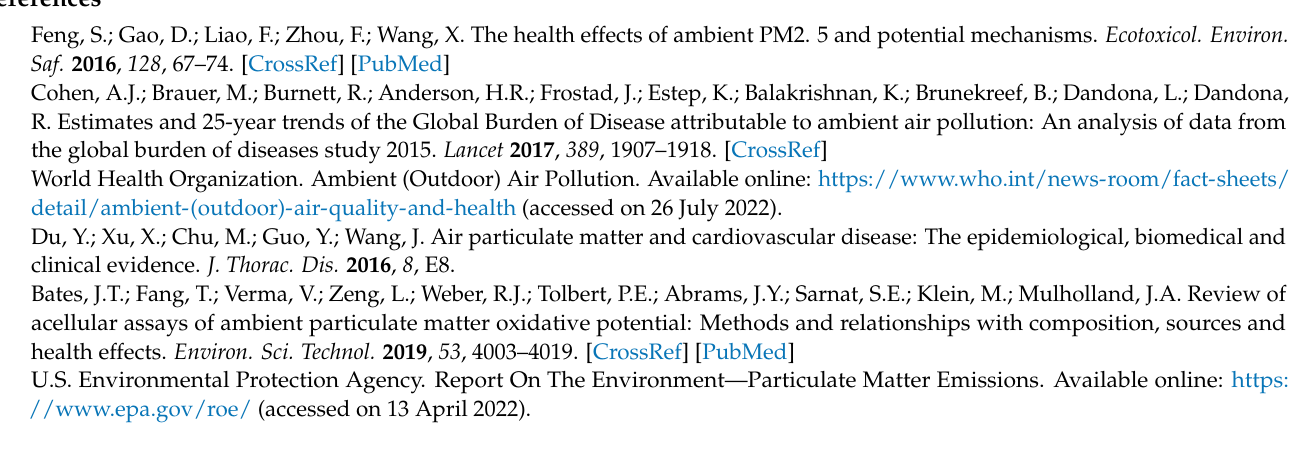
PM 2.5 and PM 10 with Decreased Cognitive Function (n = 4175). Supplementary Table S2: Relationship between Tertile of PM 2.5 and PM 10 and Cognitive Score (n = 4175). Supplementary Table S3: Asso- ciation between PM 2.5 and PM 10 and Cognitive Score by Sex (Women = 2305; Men = 1870). Sup- plementary Table S4: Association between PM 2.5 and PM 10 and Cognitive Score by Age Group (50–65 years = 1665; 65–75 years = 1483; >75 years = 1027). Supplementary Table S5: Association between PM 2.5 and PM 10 and Cognitive Score by Alcohol Consumption (Never = 2356; Former = 318; Current = 1501). Supplementary Table S6: Association between PM 2.5 and PM 10 and Cognitive Score by Physical Activity (No = 2982; Yes = 1193). Supplementary Table S7: Association between PM 2.5 and PM 10 and Cognitive Score by Smoking Status (Never = 2750; Former = 1007; Current =